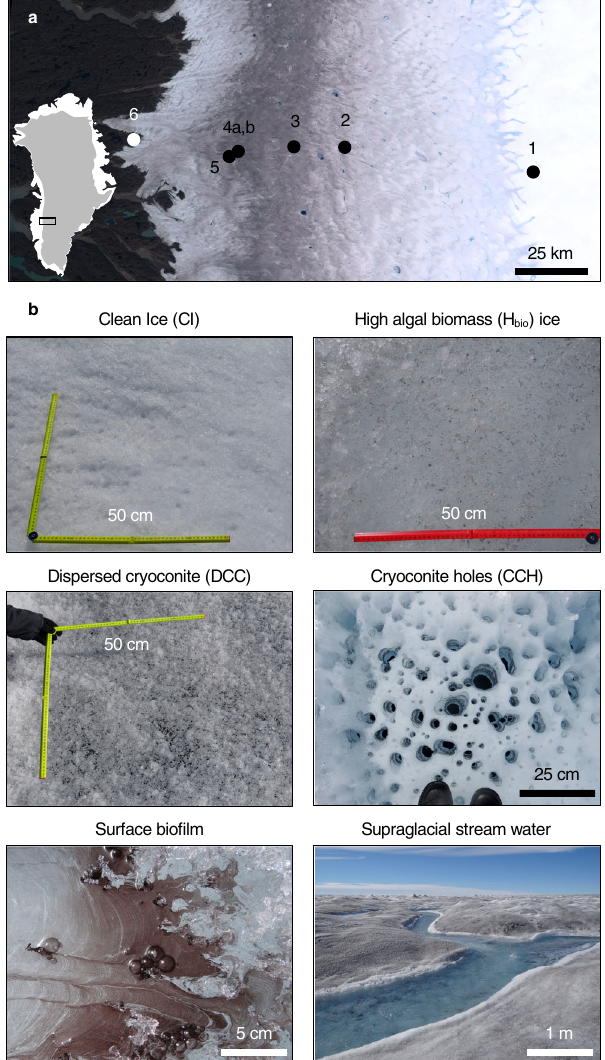
Fig. 1 Sample collection locations and habitats on the Greenland Ice Sheet. a Sample collection sites 1 – 5 across the ablation zone in southwest Greenland Ice Sheet and rock sample collection site 6 near the terminus of Russell Glacier viewed using Sentinel-2 imagery (cloud-free composite of all acquisitions between 01/07/2016 and 31/08/2016); b photographs of surface ice habitats: clean ice (CI), high algal biomass ice (H bio ), dispersed cryoconite ice (DCC), cryoconite holes (CCH), surface bio fi lm, and supraglacial stream